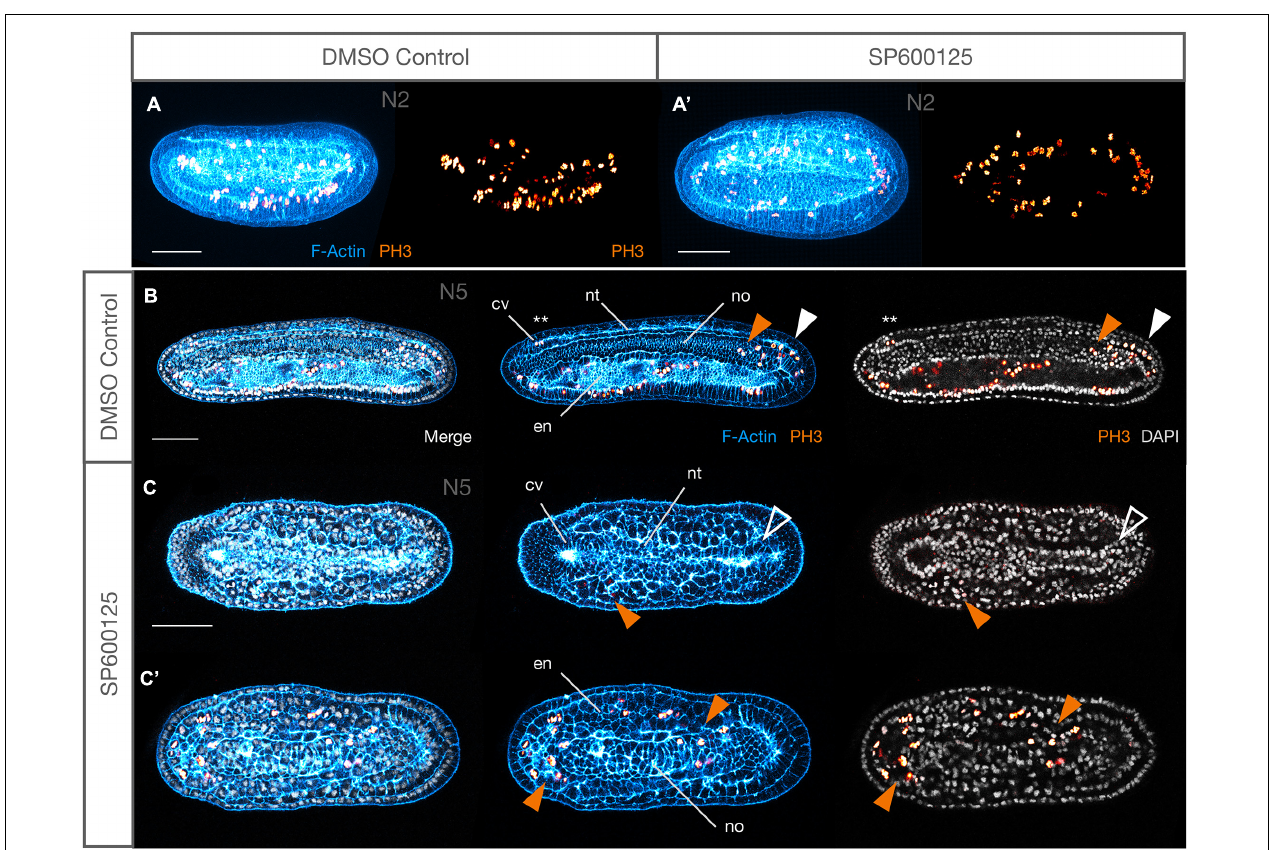
FIGURE 7 | Proliferation is maintained after JNK inhibition. (A,A (cid:48) ) Maximum projections of all confocal planes in control and SP600125-treated embryos stained for F-Actin (cyan) and phospho-histone H3 (PH3, gold) at the N2 stage showing broad distribution of mitotic cells. (B) Control N5 and (C,C (cid:48) ) stage matched treated embryos showing patterns of proliferation in different tissue types. In controls (B) , proliferation is found throughout the endoderm, but otherwise mostly localised to the posterior neural tube (white arrowhead) and notochord (orange arrowhead), and rarely in somites (not shown) or the cerebral vesicle (asterisks). In spite of dramatic size reduction in treated embryos (C,C (cid:48) ) , endoderm contains many mitotic cells as does the posterior notochord, and unusual examples of PH3 + somatic cells can be seen (orange arrowheads). No neural cells divide here, even in the posterior neural tube (white outlined arrowhead). Representative embryos are shown. In all cases anterior is to the left. Panels (A,B) are lateral views, (C (cid:48) ,C) are dorsal views of the same embryo at different confocal planes. cv, cerebral vesicle; en, endoderm; nt, neural tube; no, notochord. Scale bars = 50 µ